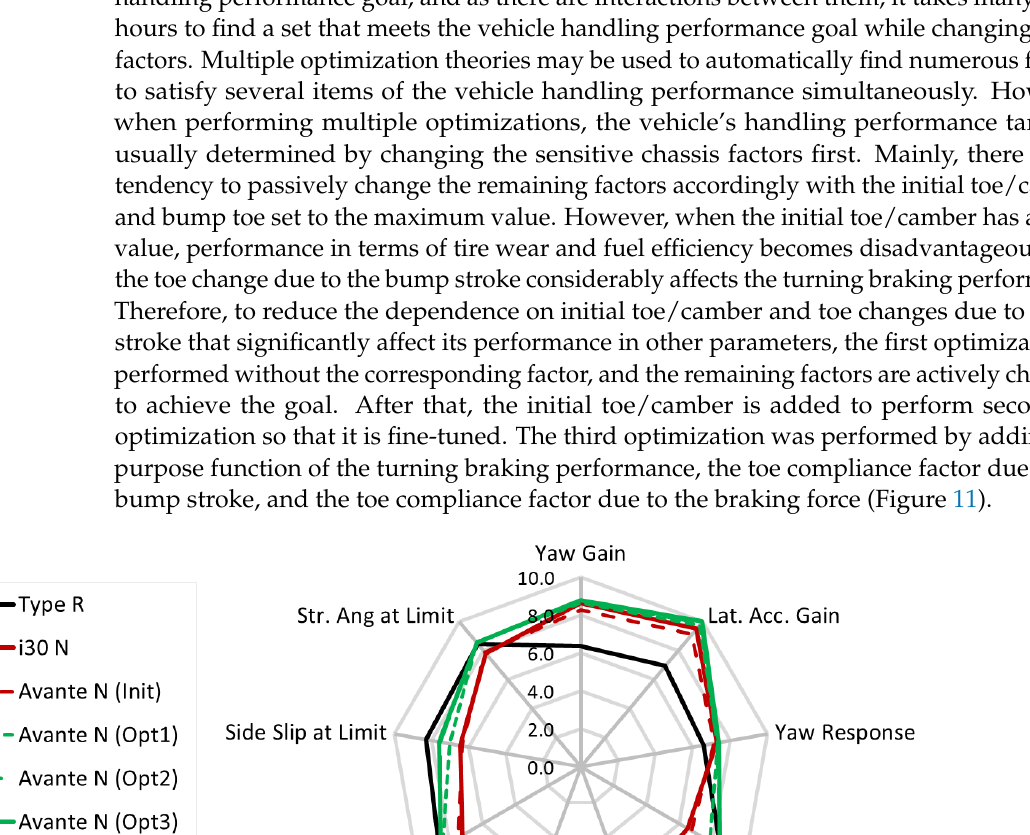
Figure 11. Optimizing handling performance (steering input).